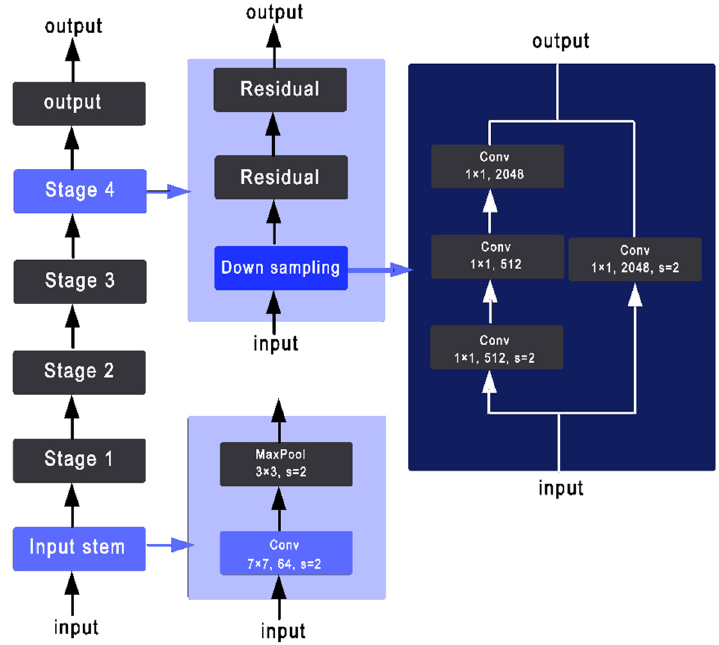
Figure 2. ResNet50 architecture.